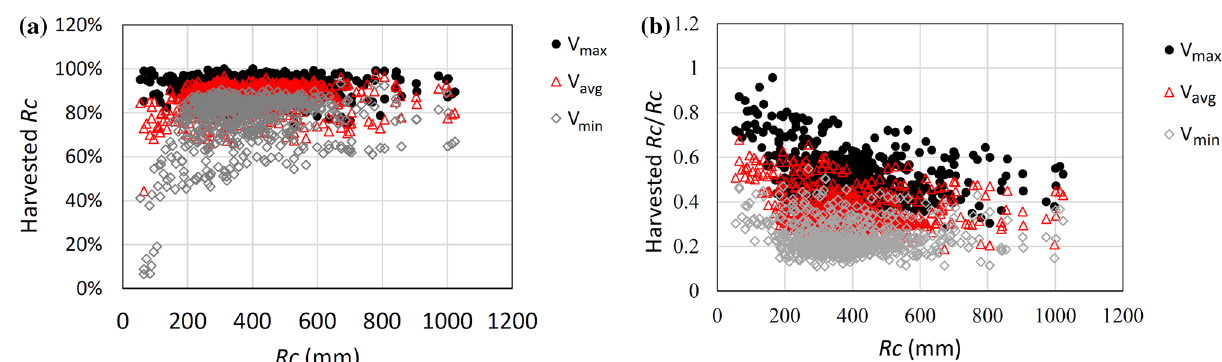
Figure 4. Runoff that could be harvested, and normalized storage volume V min versus the annual average runoff (Rc) for the case of constant withdrawal, calculated throughout the 14 year time series.